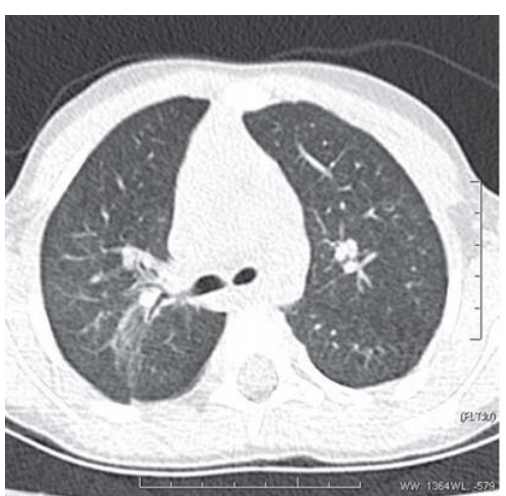
Fig. 4 - R.A.M, sexo masculino, 4 anos e 9 meses de idade e peso de nascimento de 980 gramas. Imagem obtida no campo pulmonar superior com janela para parênquima pulmonar. Presença de opacidade em vidro fosco multifocal no lobo superior direito